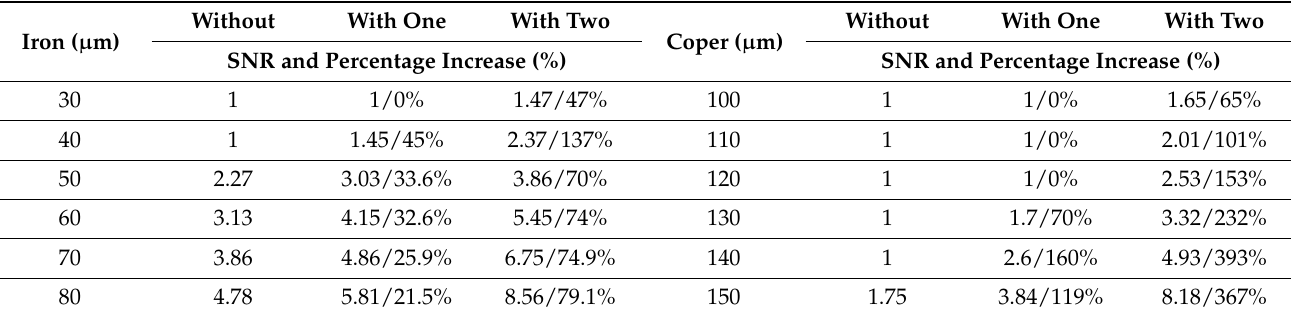
Table 1. SNR and added value in different sensors.